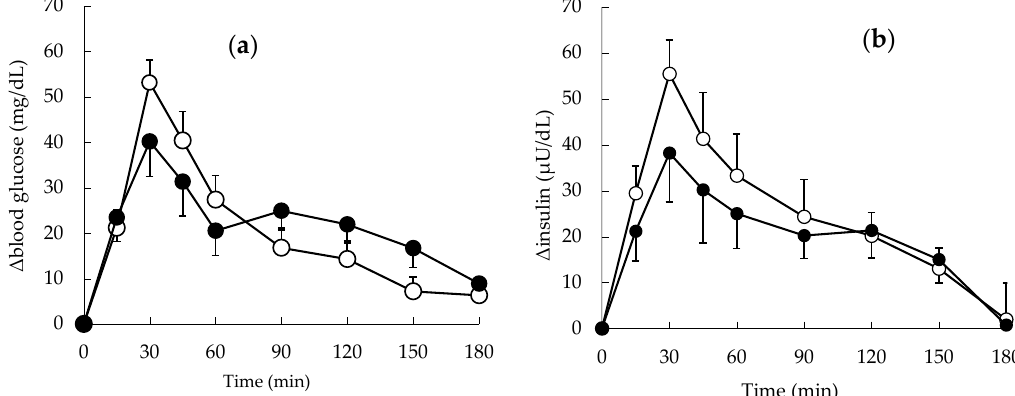
Figure 1. Changes in the postprandial blood glucose and insulin levels in healthy normal subjects. ( a ) Blood glucose. ( b ) Insulin. 〇 : rice-first group, ● : apple-first group (respectively, n = 10). No sig- nificant difference was noted between the rice-first and apple-first groups.